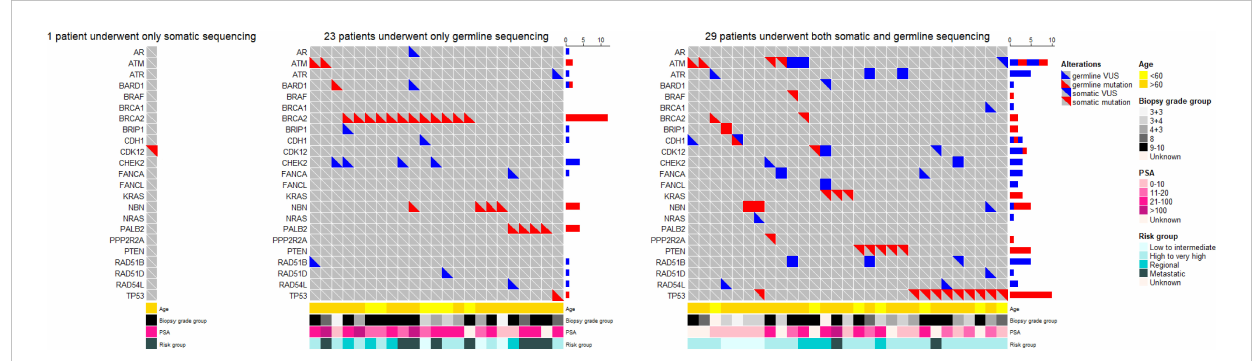
FIGURE 4 The oncoprints of somatic and germline aberrations tested using the 32-gene panel in our study. A total of 53 patients harbored either somatic or germline mutation. Among these patients, 1 patient underwent somatic sequencing only; 23 patients underwent germline sequencing only; and 29 patients underwent both somatic and germline sequencing. The VUS captured in these patients were also illustrated to provide a thorough view of genetic changes in these